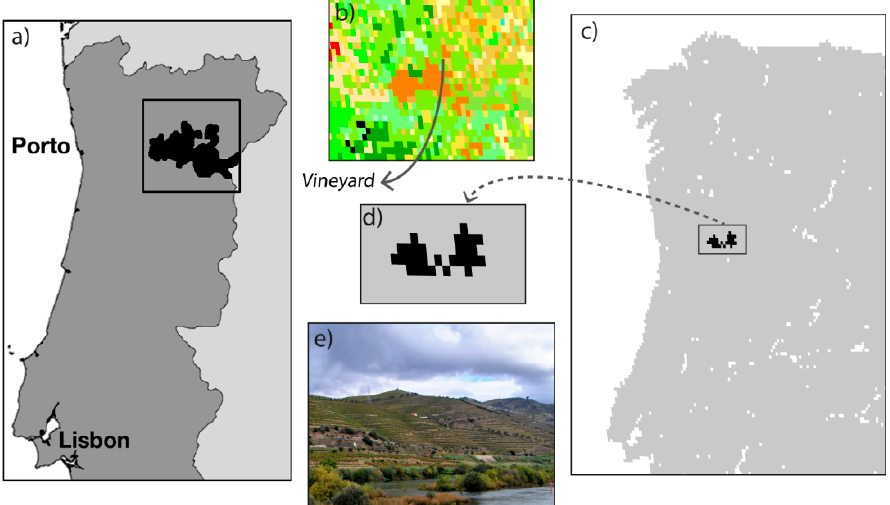
Figure 1. ( a ) Douro region and its typical vineyards landscape ( e ), ( b ) pixels classified as vineyards from the CLC map after resolution and projection matching to MSG images (example of the CLC06), ( c ) location of the selected pixels after vineyard persistence analysis, and ( d ) zoomed identification of the selected pixels used in this